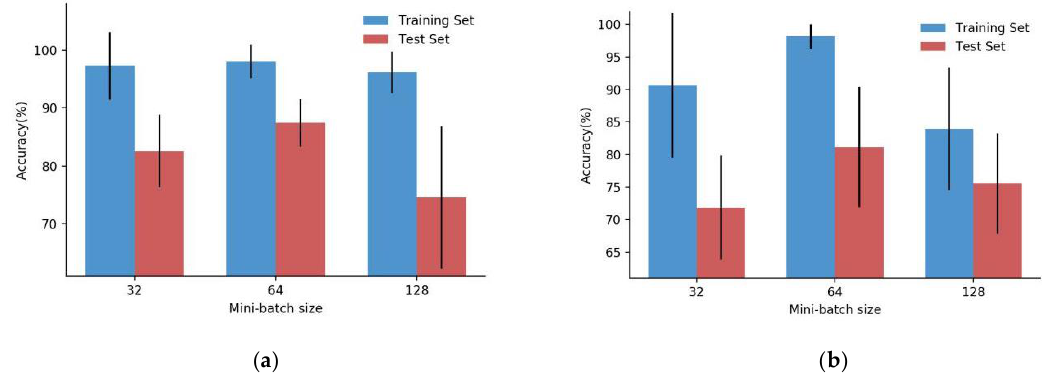
Figure 11. Comparison of accuracy with di ff erent mini-batch sizes by LCCDNNs. ( a ) C. elegans dataset, ( b ) zebrafish